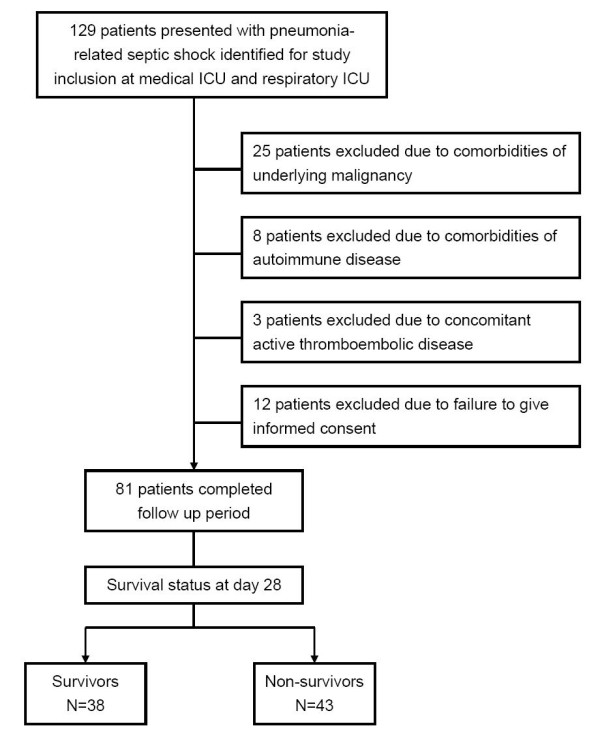
Study profile demonstrating the number of cases and reasons for exclusion. ICU, intensive care unit.